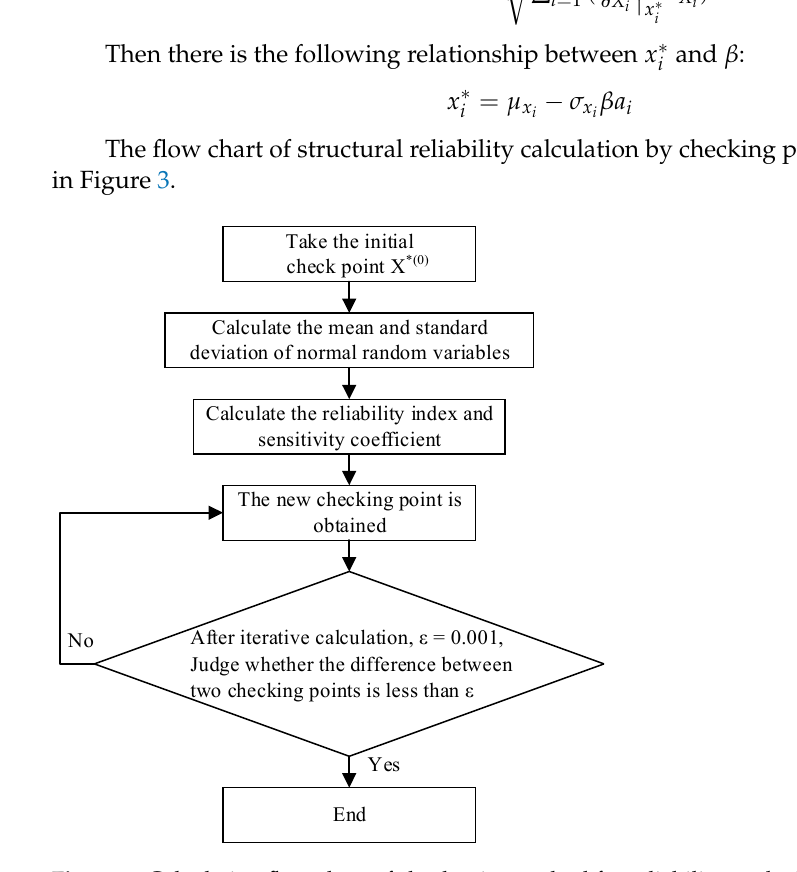
Figure 3. Calculation flow chart of checkpoint method for reliability analysis.